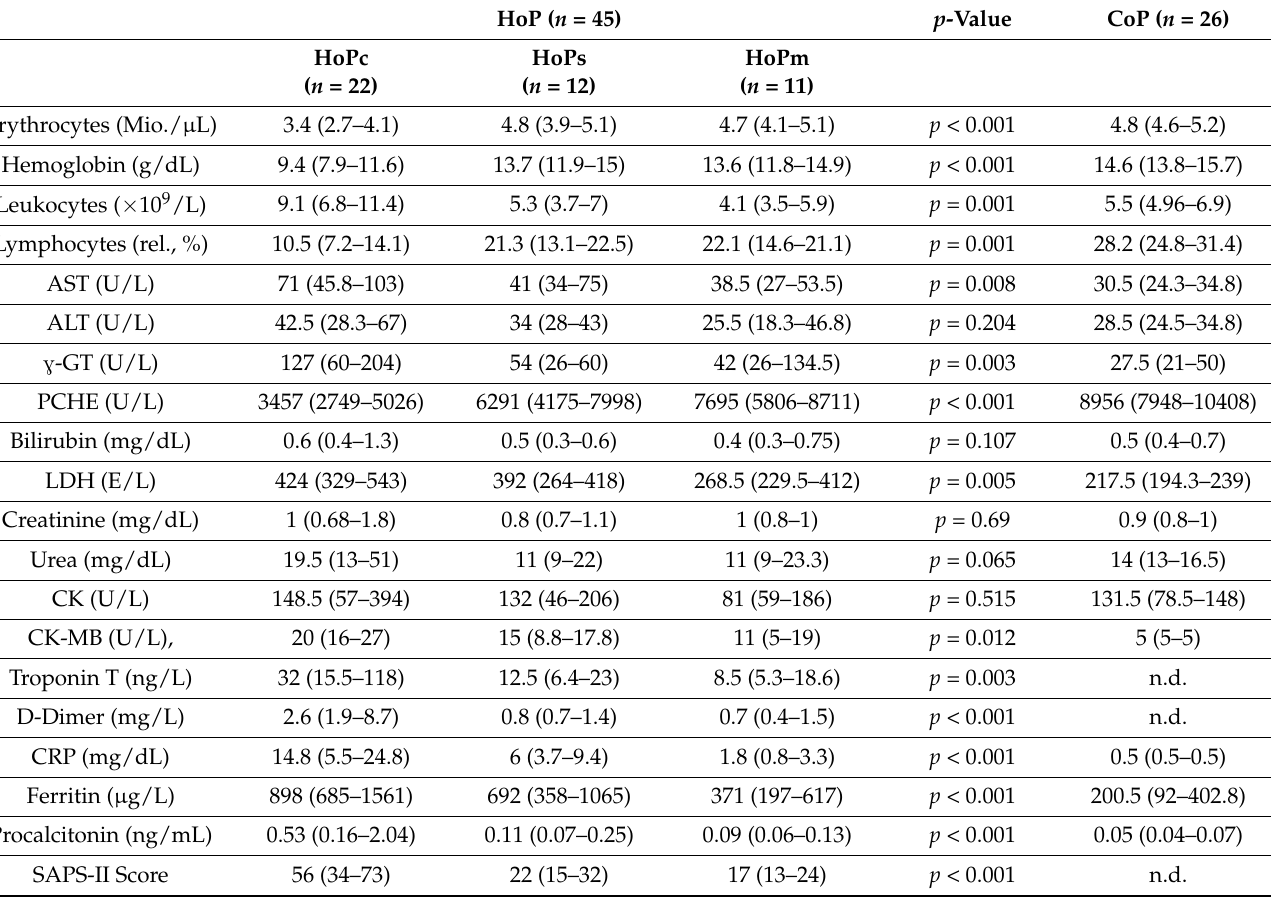
Table 2. Cohort characteristics: differences were calculated by Kruskal–Wallis test. IQR, interquartile range; AST, aspartate aminotransferase; G -GT, γ -glutamyltransferase; LDH, lactate dehydrogenase; PCHE, pseudocholinesterase; CK, creatine kinase; CRP, C-reactive protein; HoP, hospitalized patients with critical (c), severe (s) and moderate (m) disease; CoP, convalescent